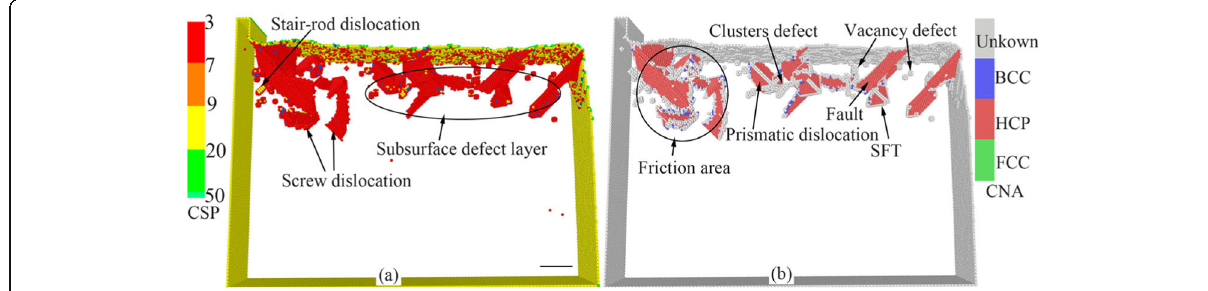
Fig. 5 Distribution of residual defects in subsurface of workpiece after nanometer cutting (color online, scale bar 5 nm). a The yellow, green, red, and blue atoms are surface atoms, surface defects atoms, subsurface defect atoms, and FCC atoms. b The green, red, gray, and blue atoms are FCC, HCP, unknown, and BCC